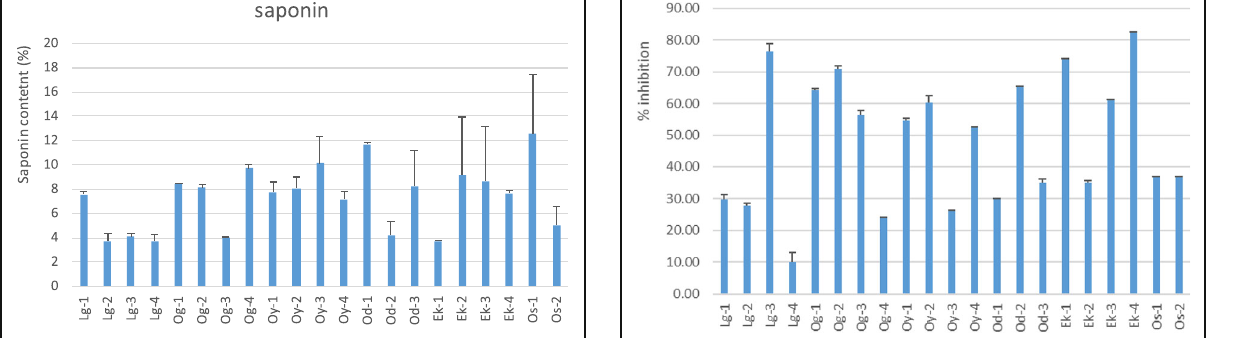
Fig. 5 Lipid peroxidation inhibition of Moringa oleifera leaf from the 21 locations. The results are mean of triplicates with the error bars (standard deviation). The chart shows significant between- and within-group differences in the inhibition of lipid peroxidation by the